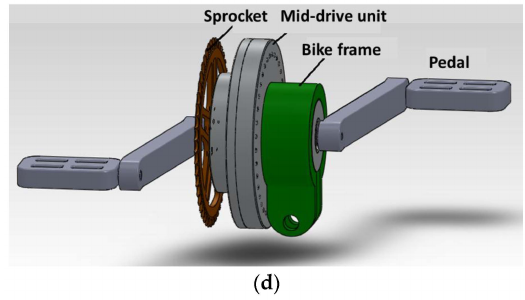
Figure 1. ( a ) Configuration of the middle motor in the mid-drive unit; ( b ) its schematic assembly with a cycloidal reducer; ( c ) the cycloidal and eccentric discs; and ( d ) the assembly of the mid-drive unit, crank, and pedals.